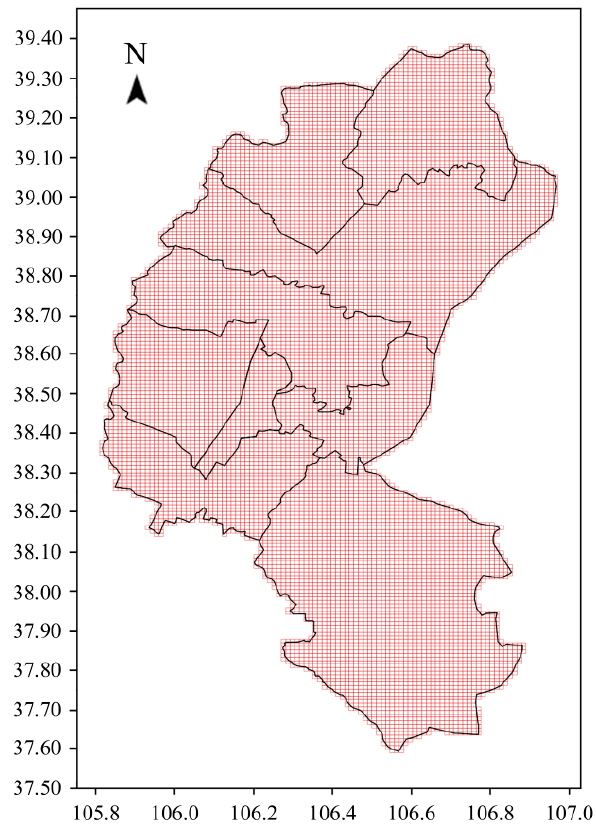
Figure 11. Grid units of the study area.